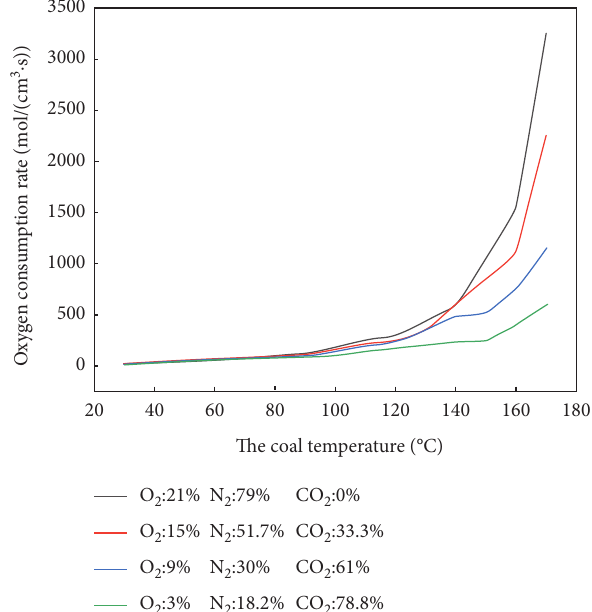
Figure 9: Oxygen consumption rate as a function of coal temperature for experimental conditions 1–4 (Table 1). 0.3